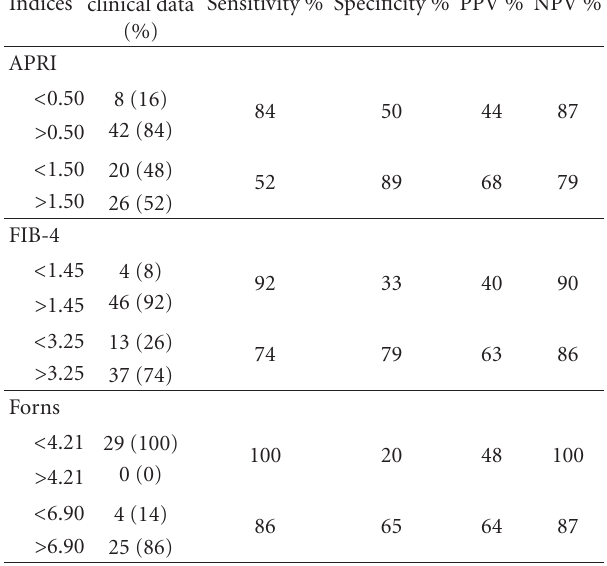
Table 2: Accuracy of the non-invasive indices in predicting signifi- cant